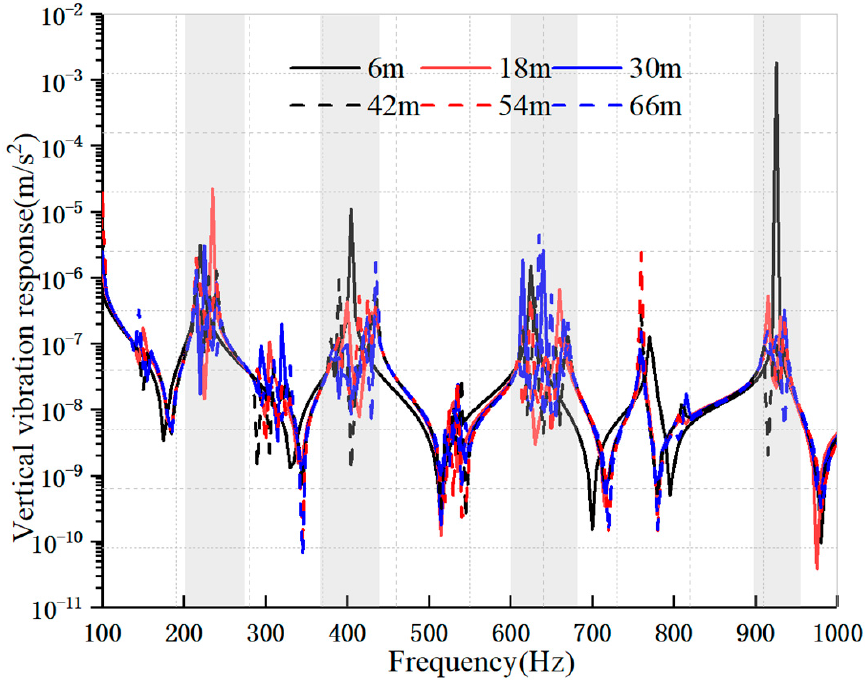
Figure 10. Vertical vibration response of the rigid catenary model with different section lengths.